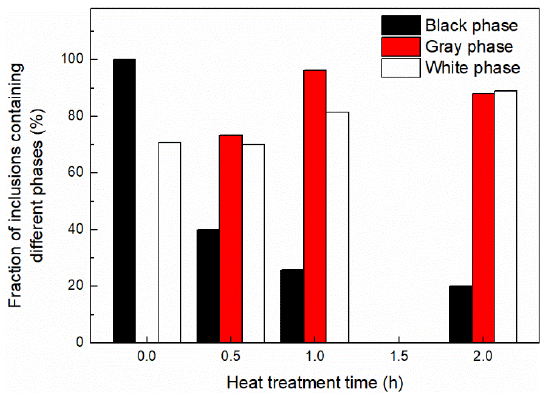
Figure 11. Fraction of inclusions containing different phases in steel #2 after heating.